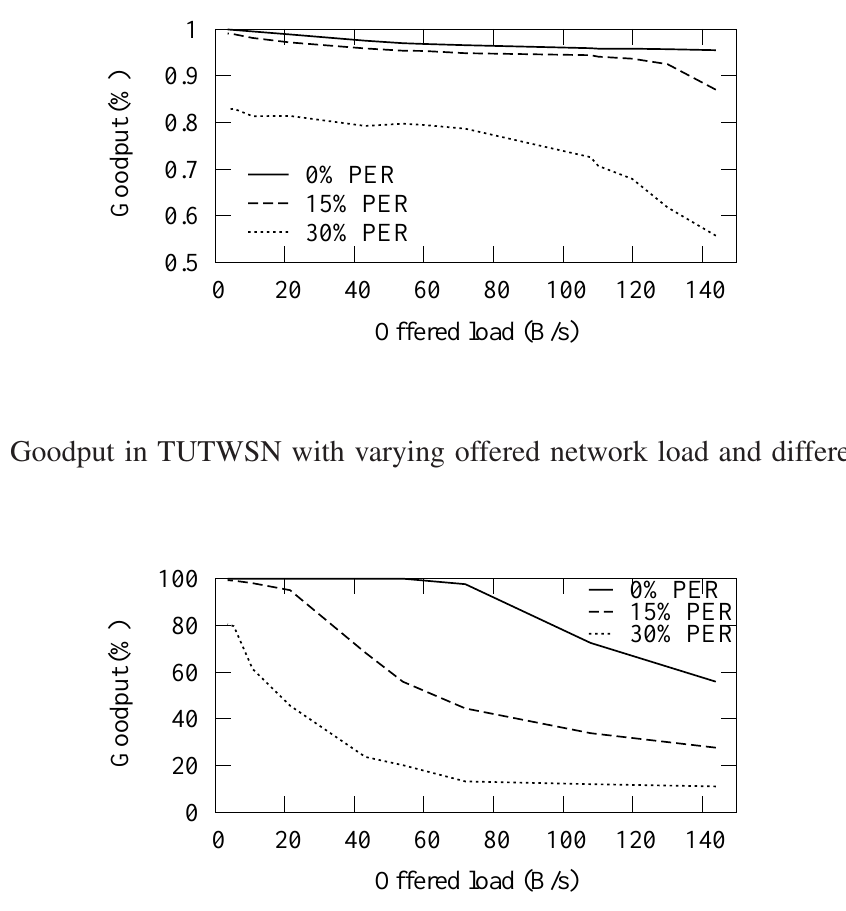
Figure 12. Goodput in ZigBee with varying offered network load and different packet error rates.